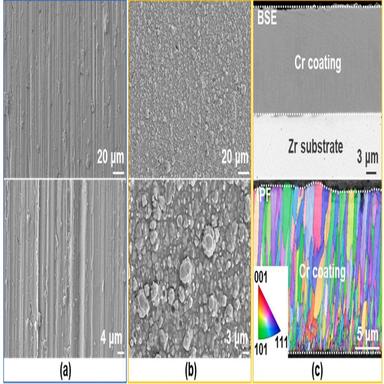
(a) Surface morphologies of the uncoated Zr alloy; (b) surface morphologies of the as-deposited Cr coating; and (c) cross-sectional SEM image and EBSD inverse pole figure (IPF) of the Cr-coated cladding.